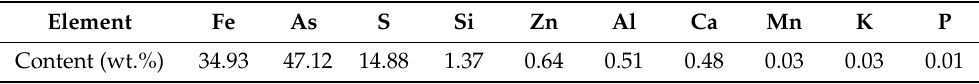
Table 1. Chemical element analysis of arsenopyrite. Element Fe As S Si Zn Al Ca P Content